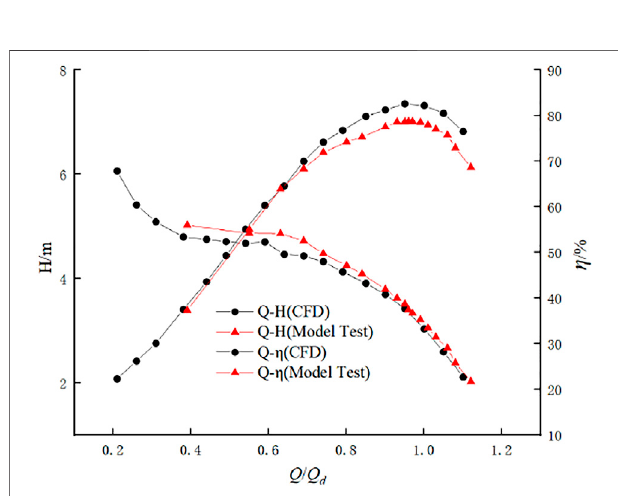
Figure 1 , and compared with the existing model experiments. In